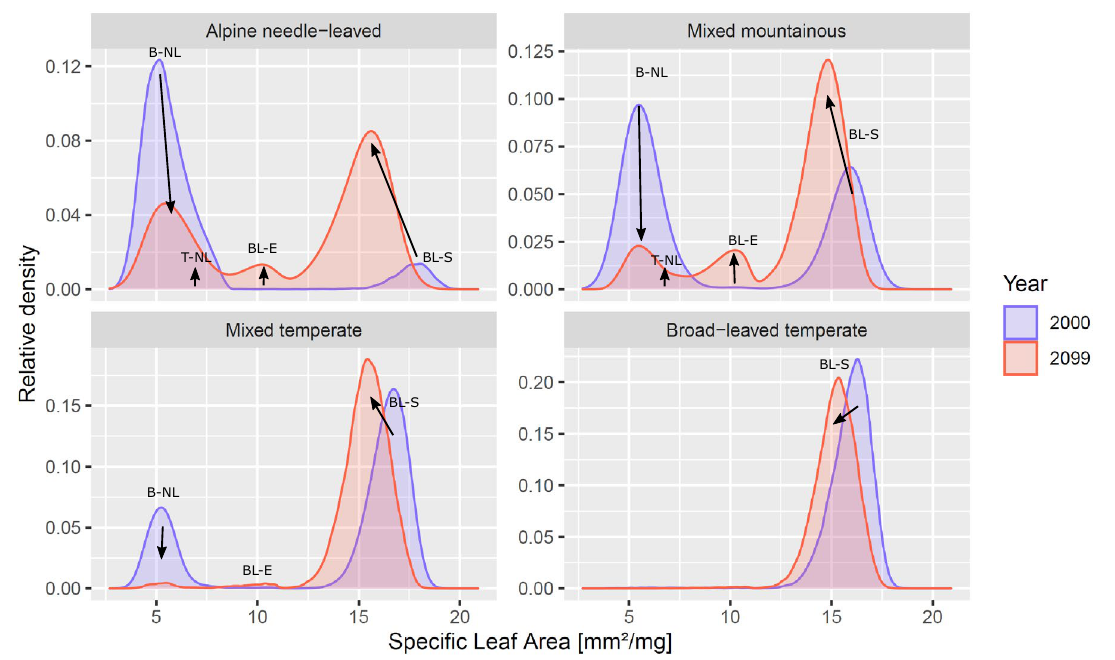
Figure 4. Trait distributions of specific leaf area in year 2000 and 2099, respectively, under future climate change (RCP 4.5). Arrows indicate trait shifts within plant functional types: BL-S Broad-leaved summergreen, BL-E Broad-leaved evergreen, T-NL Temperate needle-leaved, B-NL Boreal needle-leaved. For more detailed distributions see Supplementary Figs. S3 and